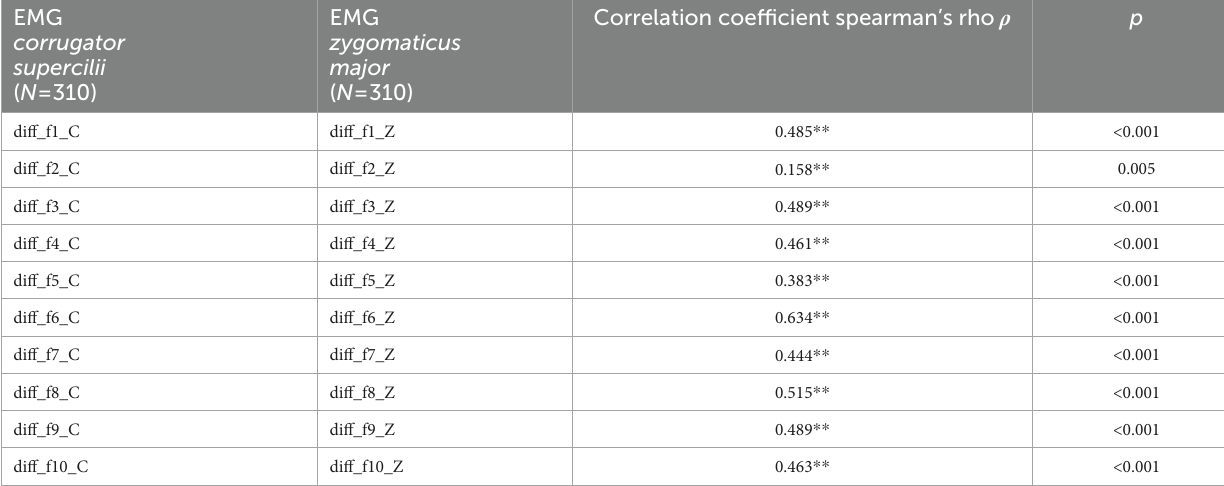
TABLE 3 Results of the non-parametric correlation analyses between EMG_corrugator_supercilii and EMG_zygomaticus_major. EMG